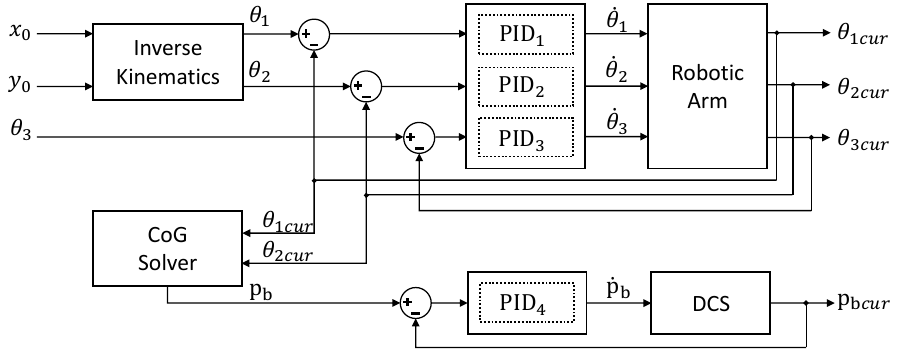
Figure 6. Control diagram of the Displacement Compensation System (DCS) and robotic arm. CoG = Center of